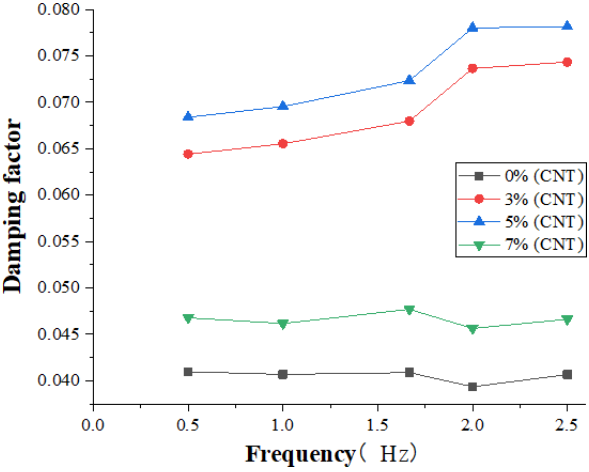
Figure 8: Loss factors for MWCNTs-reinforced UHPC with different